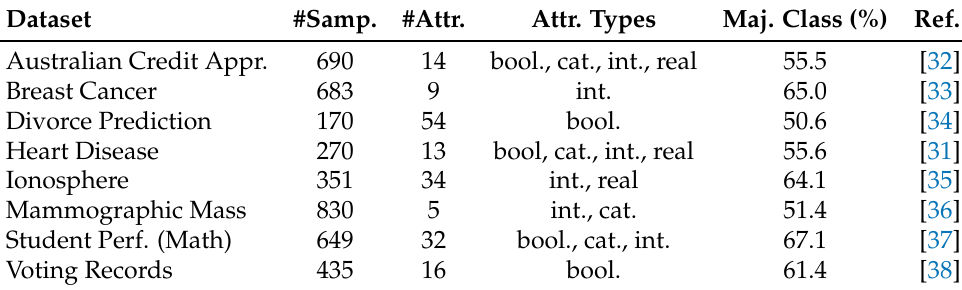
Table 1. Datasets used in the experiments. From left to right, the columns designate: number of samples; number of input features; types of features (Boolean, categorical, integer, real); proportion of samples in the majority class;